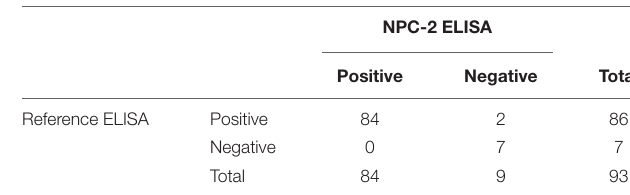
TABLE 3 | Comparison of ELISA assays in determining SARS-CoV-2 antibodies in serum samples from patients confirmed by